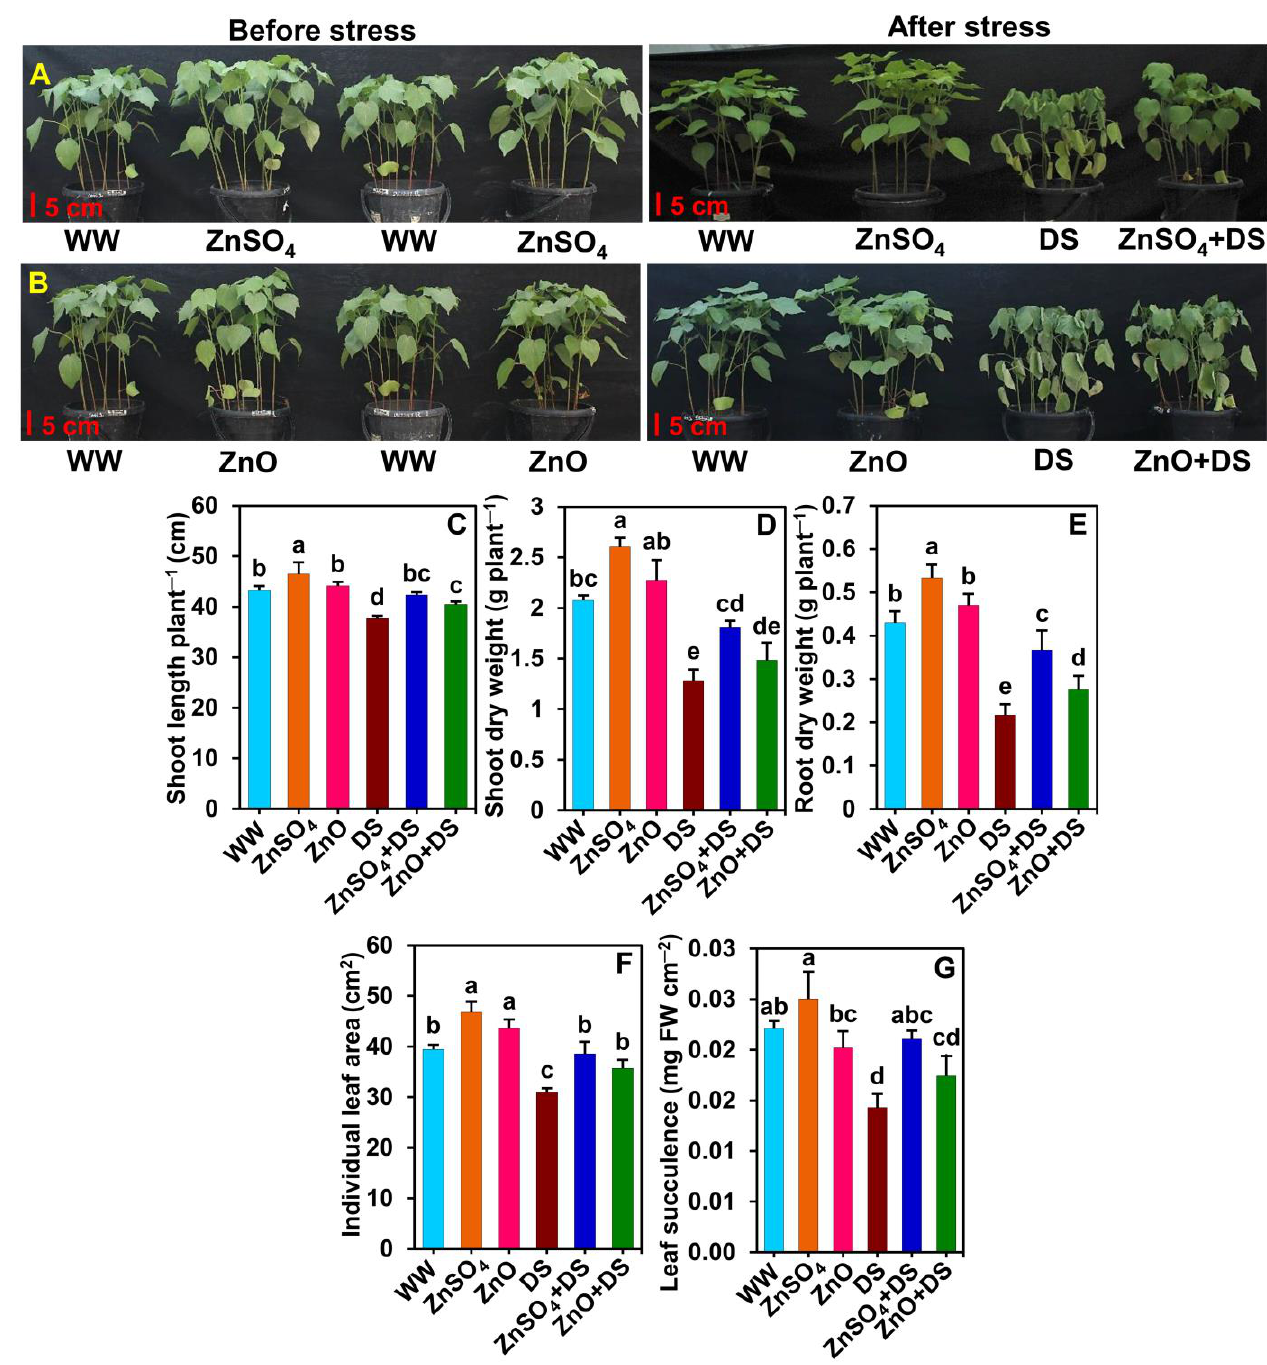
Figure 1. Effect of separately applied ZnSO 4 (1.0 g Kg −1 soil) and ZnO (1.0 g Kg −1 soil) on cotton plants that were subjected to water deprivation-induced drought stress for 6 days. ( A , B ) Cotton plants were photographed before and after being subjected to drought stress. ( C ) Shoot length, ( D ) shoot dry weight, ( E ) root dry weight, ( F ) individual leaf area, and ( G ) leaf succulence of cotton plants under different treatments. The means and standard deviations ( n = 3) are displayed as bars. Significant changes ( p < 0.05) among the treatments are denoted by different letters (a – e) above the bars as calculated using the least significant difference test. Here, the treatments are well-watered plants (WW), ZnSO 4 -supplemented well-watered plants (ZnSO 4 ), ZnO-supplemented well- watered plants (ZnO), drought-stressed plants (DS), ZnSO 4 -supplemented drought-stressed plants (ZnSO 4 + DS), and ZnO-supplemented drought-stressed plants (ZnO + DS). FW, fresh